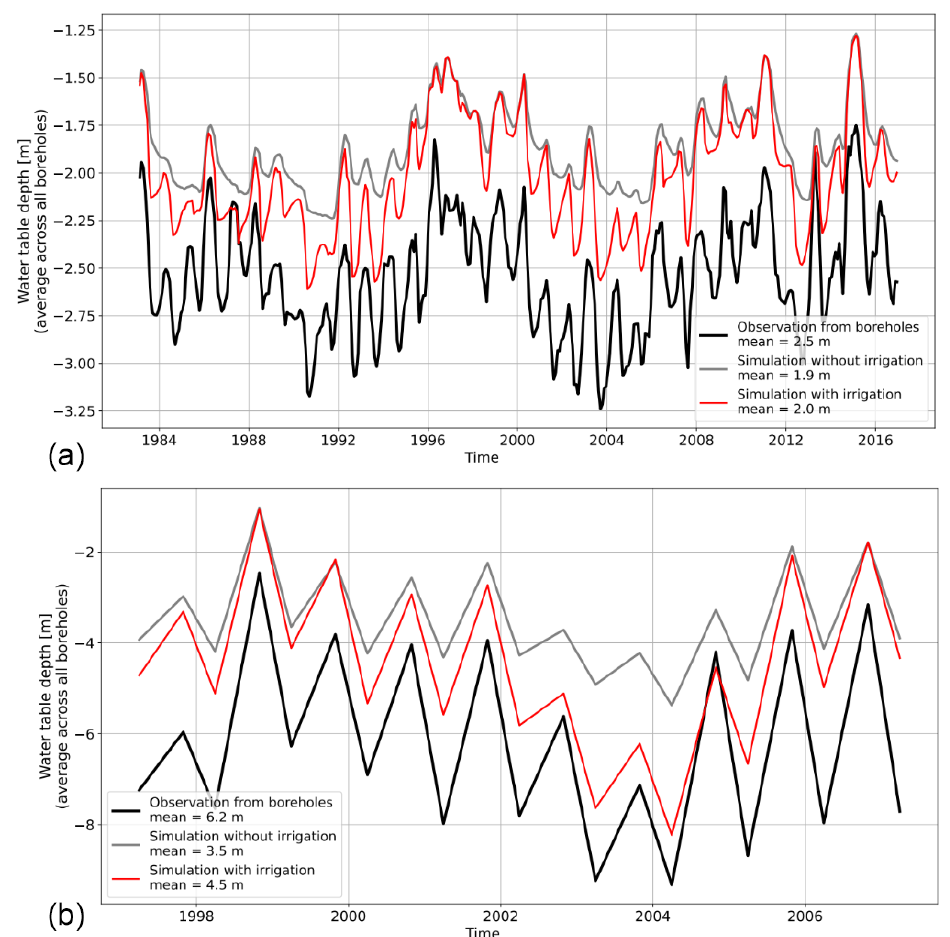
Figure 6. Comparison between absolute water table depth fluctuations obtained from CWatM with (red lines) and without (gray lines) irrigation in the Seewinkel (a) and Bhima (b) areas. Black lines represent observed data. Water table depth fluctuations are aggregated from 62 and 351 boreholes for Seewinkel and Bhima,